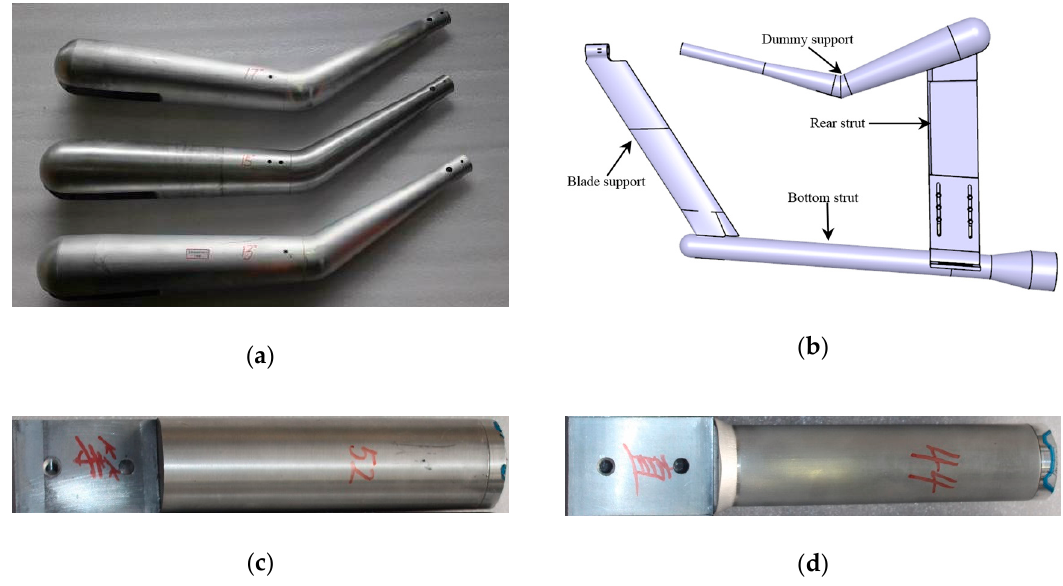
Figure 15. Verification test equipment of the dummy V-shaped support with di ff erent inflection angles (P = 13 ◦ / 15 ◦ / 17 ◦ ) and di ff erent straight-section diameters (D = 52 mm / 44 mm): ( a ) dummy V-shaped supports with di ff erent inflection angles; ( b ) verification equipment in the wind tunnel; ( c ) straight section of the dummy V-shaped support with D = 52 mm, before the mechanical cutting; ( d ) straight section of dummy V-shaped support with D = 44 mm, after the mechanical cutting.